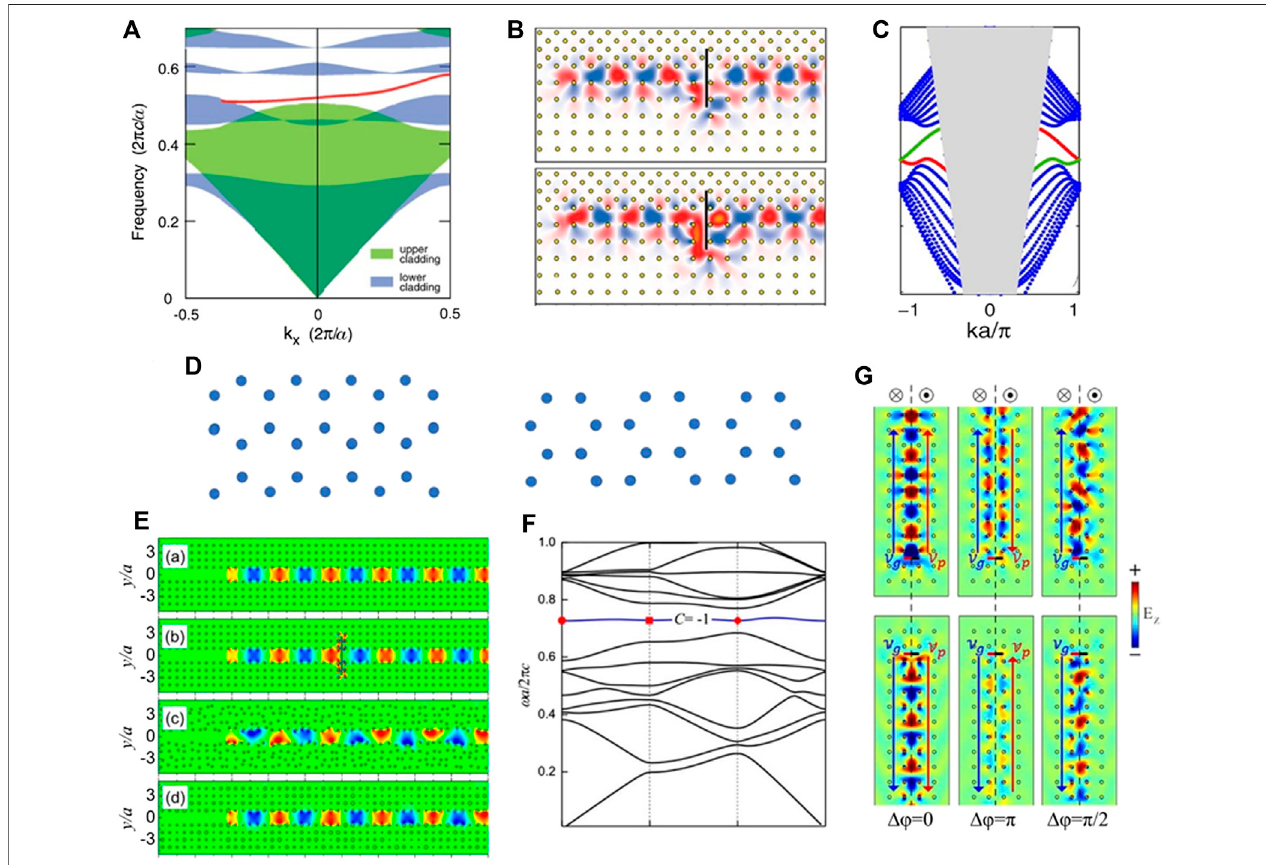
FIGURE1|(A) Thedispersioncurve oftheone-wayedgestate spans thebandgapforthecladdingcrystals(Wanget al., 2008). (B) The simulation oftheone-way waveguide with t (cid:2) 0 and t (cid:2) 0.25T 0 ( T 0 is the optical period) maintains complete transmission even inserting a slab of a perfect electrical conductor (Wang et al., 2008). (C) Bandstructureofself-guidingedgestate,inwhichthelightconeisshadedandtheedgestatesareshowninredandgreen(Aoetal.,2009). (D) Thezigzagedgeand the armchair edge. (E) The one-way transportation of EM wave in four con fi gurations: without defects and disorder, with defects, with position disorder, and with radius disorders (Liu et al., 2010). (F) Flat band with nonzero Chern number is denoted by colored lines (Yang et al., 2017b). (G) Symmetrical and antisymmetrical one- way transportation of EM wave (Lai et al., 2020).